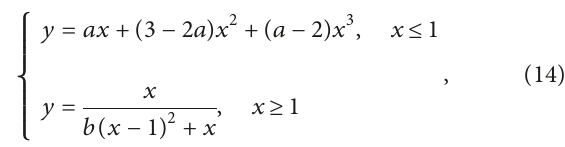
Figure 9: Temperature distribution on beam central line for different section sizes. (a) 150mm